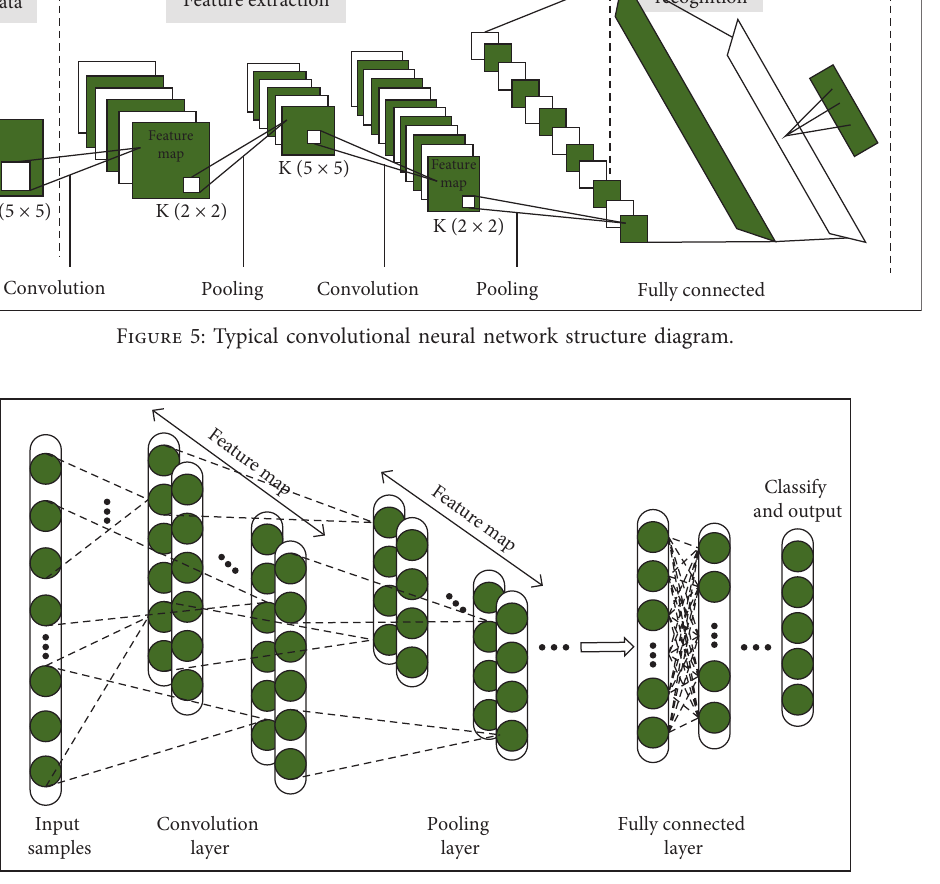
Figure 6: One-dimensional convolutional neural network structure diagram.